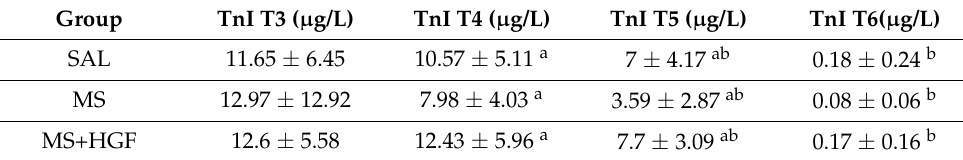
Table 3. Mean values of TnI.